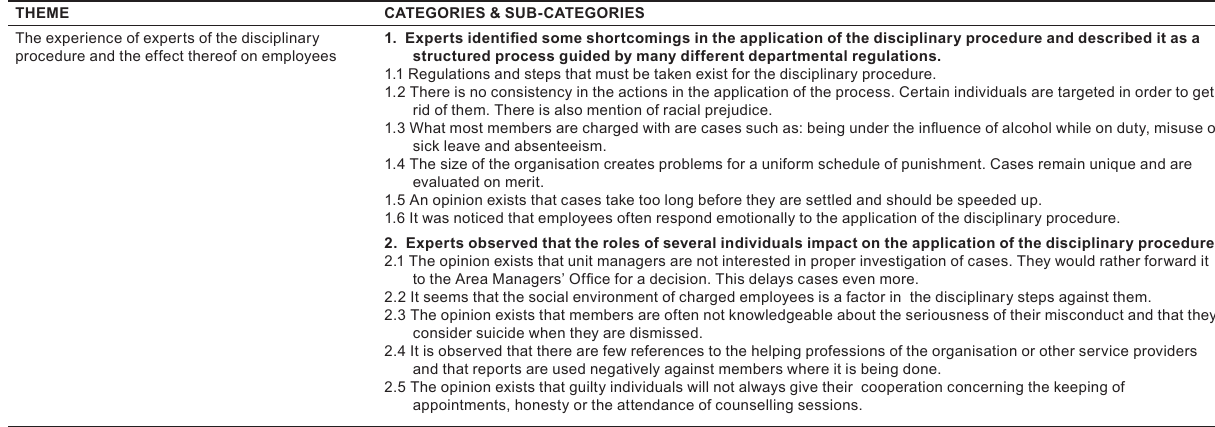
TABlE 2 An overview of themes, categories and sub-categories of the experience of the expert participant group of the disciplinary